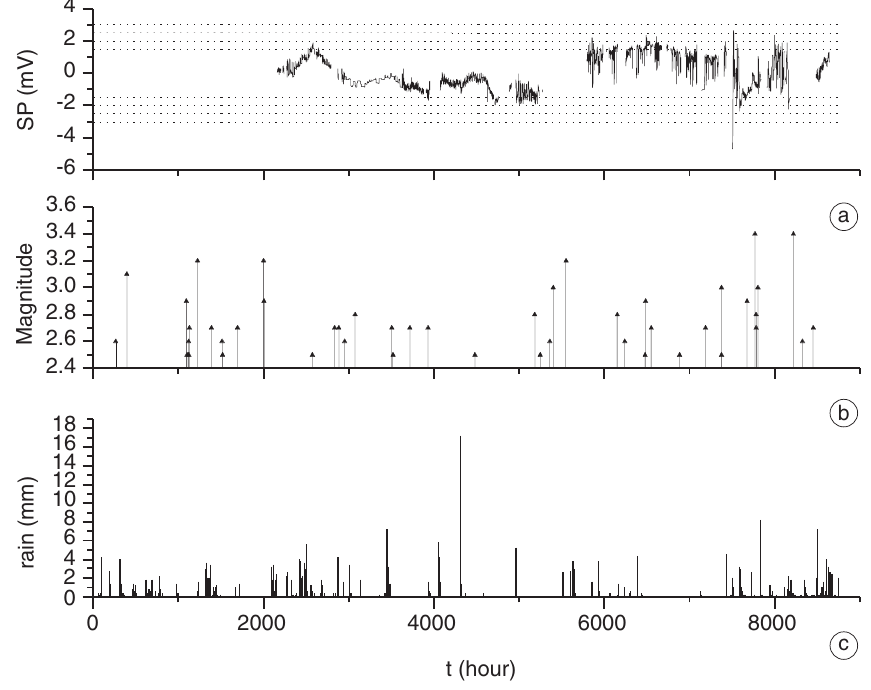
Fig. 2a-c. a) Normalized self-potential data recorded at Tito station during the 2001. The horizontal dotted lines indicates the thresholds T = ± 1.5 σ , ± 2.0 σ , ± 2.5 σ , and ± 3.0 σ . The Extreme Event (EE) is defined if | s | ≥ T . b) Earthquakes (EQ) with magnitude M ≥ 2.5 which occurred in the investigation area during the 2001. c) Rain data (RR) recorded for the Tito